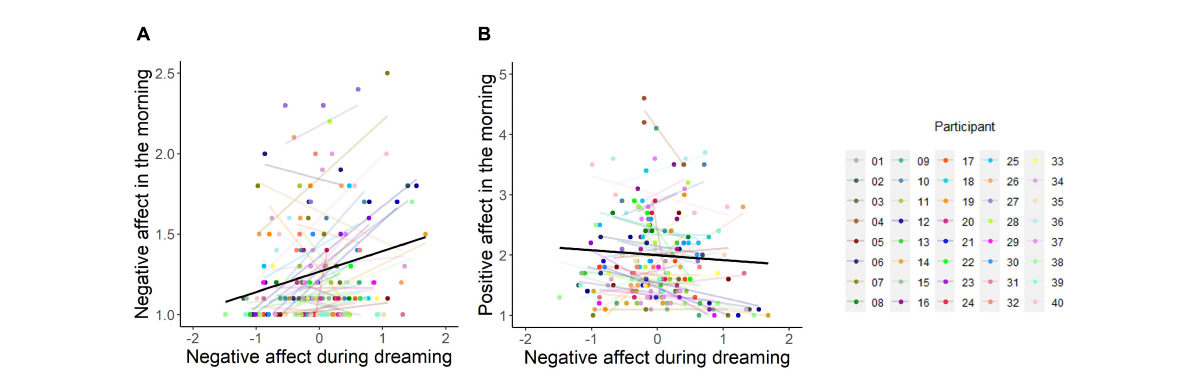
FIGURE3 Relationship between negative affect experienced in dreams and subjective ratings of post-sleep negative affect (A) and positive affect (B) the following morning. Figures are displayed for visualization purposes only since analyses were based on linear mixed-effects models with covariates. The black fitted line indicates model prediction, whereas each colored line represents a regression line for each individual participant. Dots of the same color indicate repeated measurements within a participant. Negative affect during dreaming has been group-mean centered, reflecting variation around each participant’s own mean values. The y-axis on panel A has been truncated to better visualize individual regression lines.